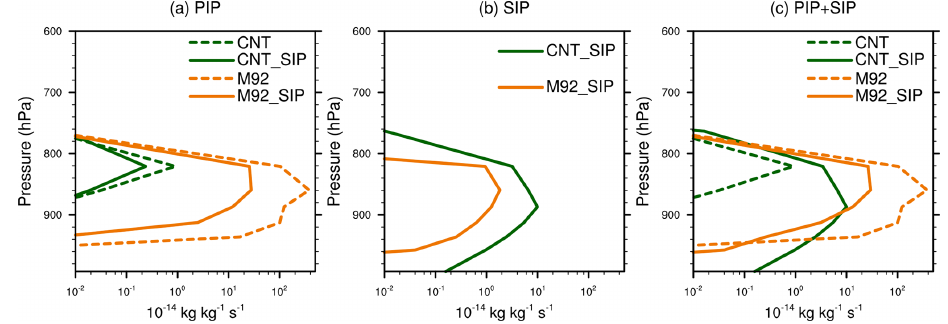
Figure 8. Vertical profiles of (a) primary ice production rate (unit: kgkg − 1 s − 1 ), (b) secondary ice production rate (unit: kgkg − 1 s − 1 ), and (c) primary plus secondary ice production rate (unit: kgkg − 1 s − 1 ) from CNT, CNT_SIP, M92, and M92_SIP model experiments averaged over the single-layer mixed-phase cloud period. Ice production rates are grid-box